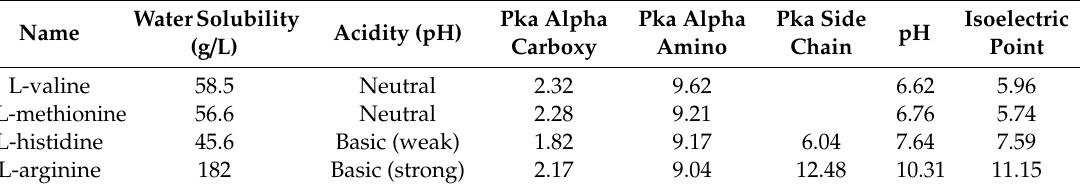
Table 2. Selected amino acids and their chemical